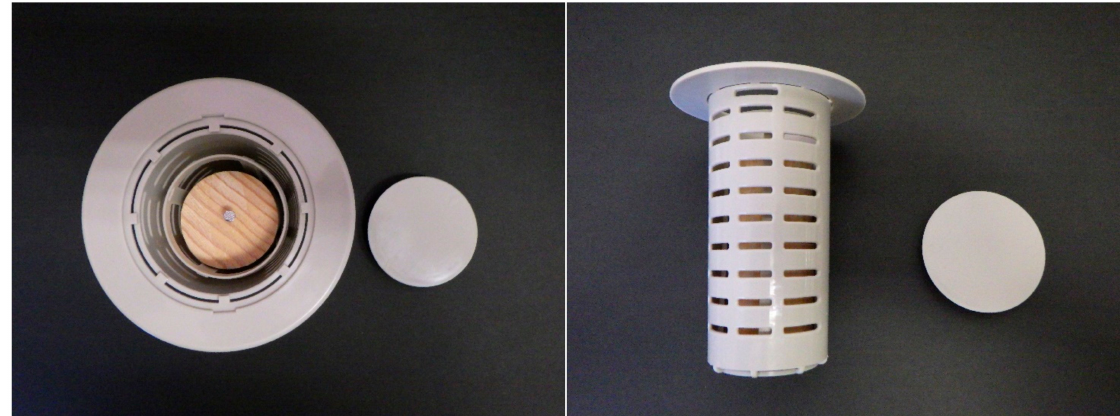
Figure 1. “Substec TM station mini” with lid open and wood bait inside. Left : top view; Right : side view.